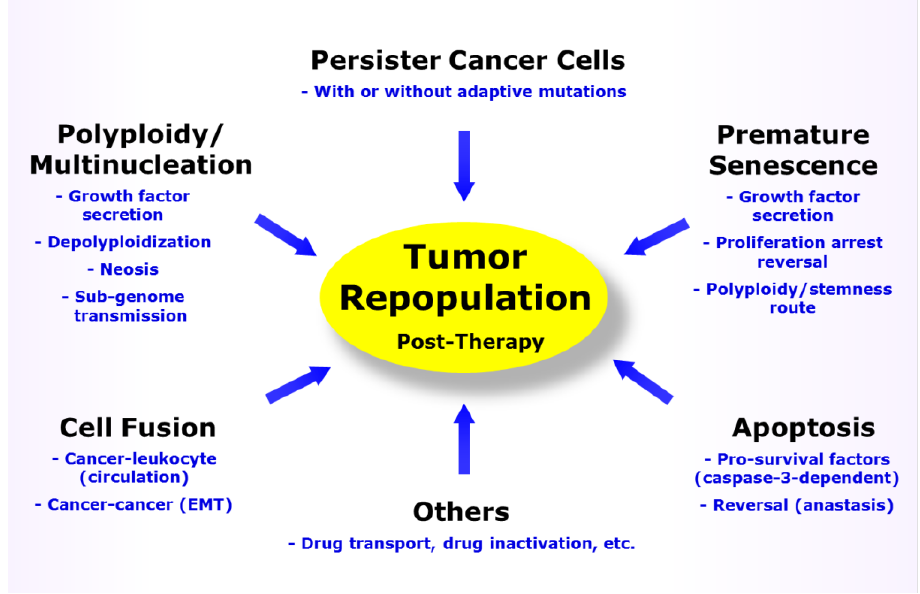
Figure 1. Responses contributing to solid tumor repopulation following treatment with anticancer agents. EMT, epithelial to mesenchymal transition.